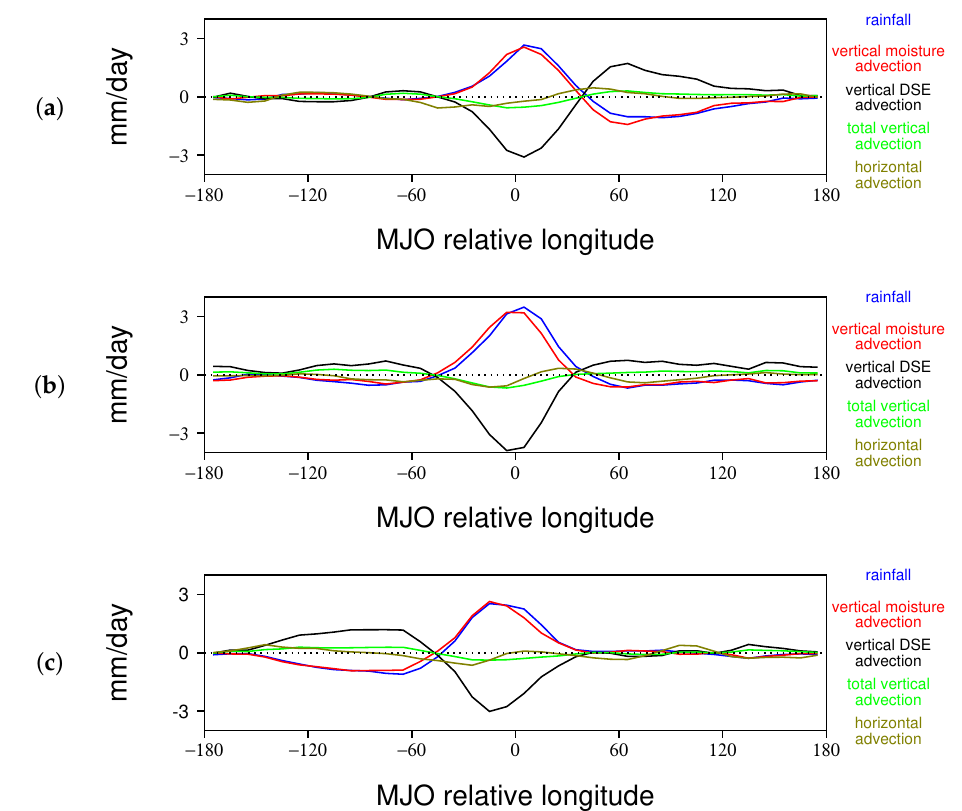
Figure 6. Components of moist enthalpy advection for the LAM MJO. Rainfall (blue line), moisture tendency from vertical advection (red line), moist enthalpy tendency from vertical advection of dry static energy (black line), total moist enthalpy tendency from vertical advection (green line), and moist enthalpy tendency from horizontal advection (gold line). Panels ( a – c ) are for the developing, mature, and dissipating stages of the MJO,